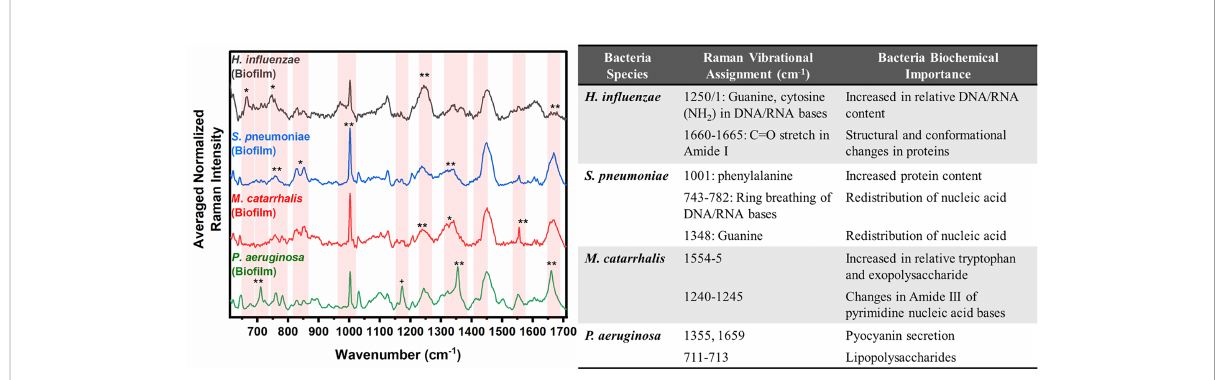
FIGURE 2 Averaged Raman spectra (left) highlighting key Raman features identi fi ed by SMLR to differentiate OM-causing bacterial bio fi lms. The table (right) provides a summary of the tentative biochemical assignments for the Raman peaks with 80% and above weighted feature contribution to the differentiation. The red bands highlight the wavenumbers with SMLR weighted features contributing to *60-79% and ** ≥ 80% in differentiating amongst the species ’ bio fi